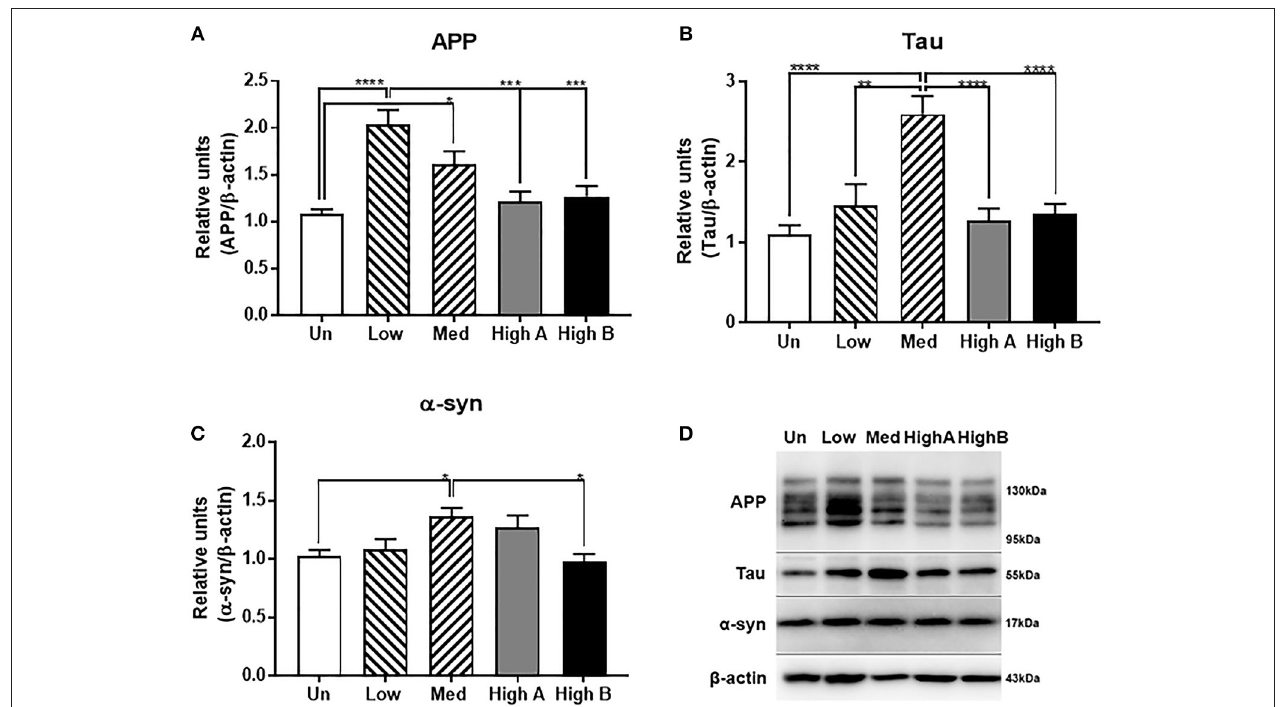
FIGURE 5 | Expression of neuronal disease-associated proteins in FtMt clones. (A) Relative levels of amyloid precursor protein (APP) in different FtMt clones. Results shown represent mean ± SEM of triplicate experiments. Data analyzed by One way ANOVA with Tukey’s post-hoc test of significance. Results indicate level of significance. * p < 0.05; ** p < 0.01, *** p < 0.001, **** p < 0.0001. (B) Relative levels of Tau in different FtMt clones. Results shown represent mean ± SEM of triplicate experiments. Data analyzed by One way ANOVA with Tukey’s post-hoc test of significance. Results indicate level of significance. * p < 0.05; ** p < 0.01, *** p < 0.001, **** p < 0.0001. (C) . Relative levels of α -synuclein ( α -syn) in different FtMt clones. Results shown represent mean ± SEM of triplicate experiments. Data analyzed by One way ANOVA with Tukey’s post-hoc test of significance. Results indicate level of significance. * p < 0.05. (D) Composite Western blot showing pattern